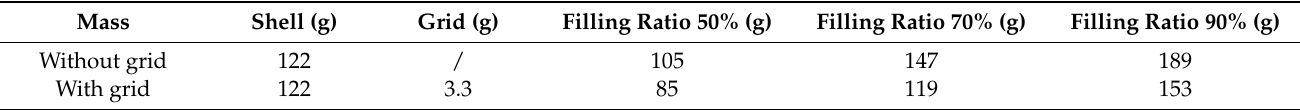
Table 1. Different filling ratio particles and model masses in the experiment.